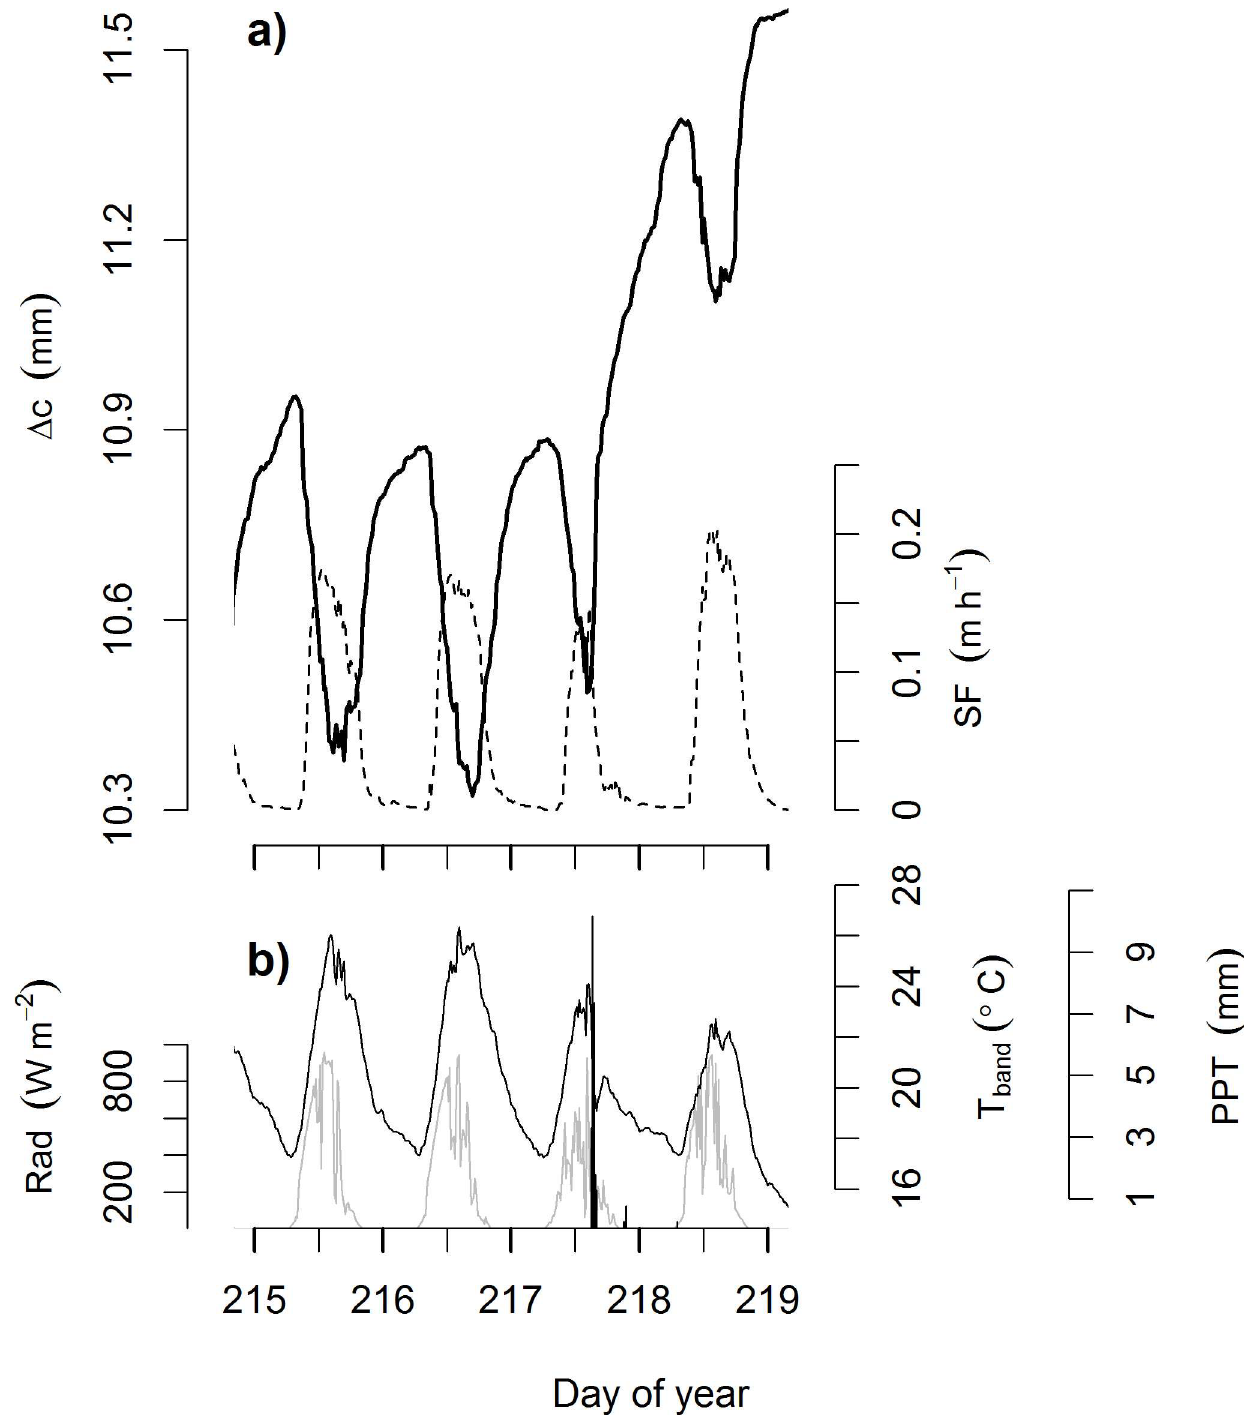
Fig 3. Example record illustrating patterns of tree circumference dynamics that align with physiological expectations. (a) Changein circumference relativeto the start of the measurement record ( Δ c ; solid line) and sap flow ( SF ; dashed line) measuredon a 70 cm DBH Liriodendron tulipifera at SCBI; (b) band temperature ( T band ; black line), solar radiation( Rad ;grey line), and precipitation( PPT ; vertical black lines).